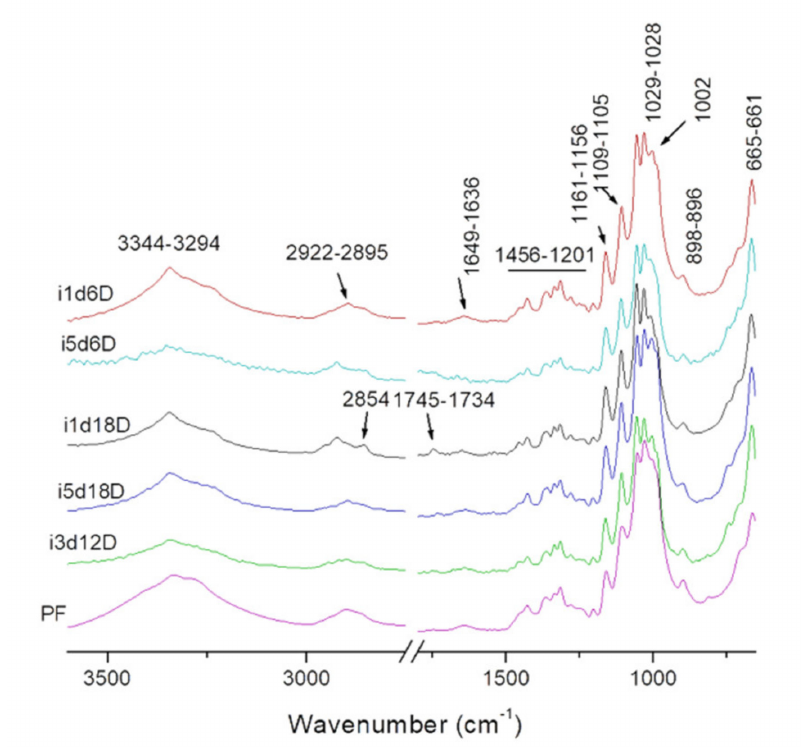
Figure 3. FTIR spectra of bacterial cellulose and filter paper on 650–3600 cm − 1 domain. PF—filter paper, i—inoculum, d—harvest day, M—moist membrane, D—dry membrane; the number